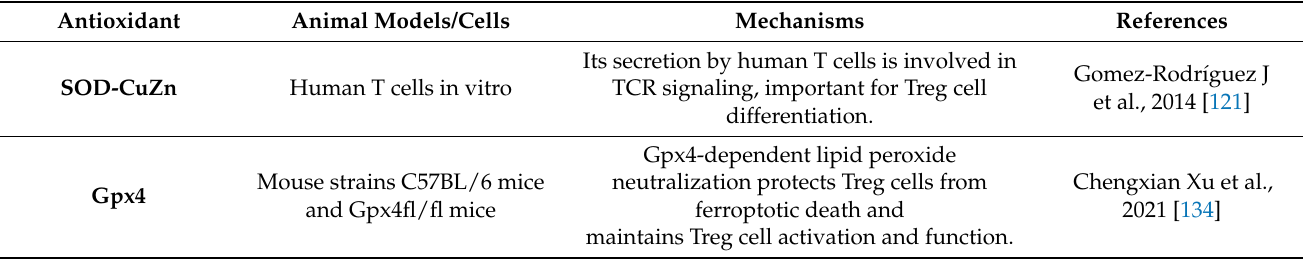
Table 1. The effect of endogenous and exogenous antioxidants on Treg